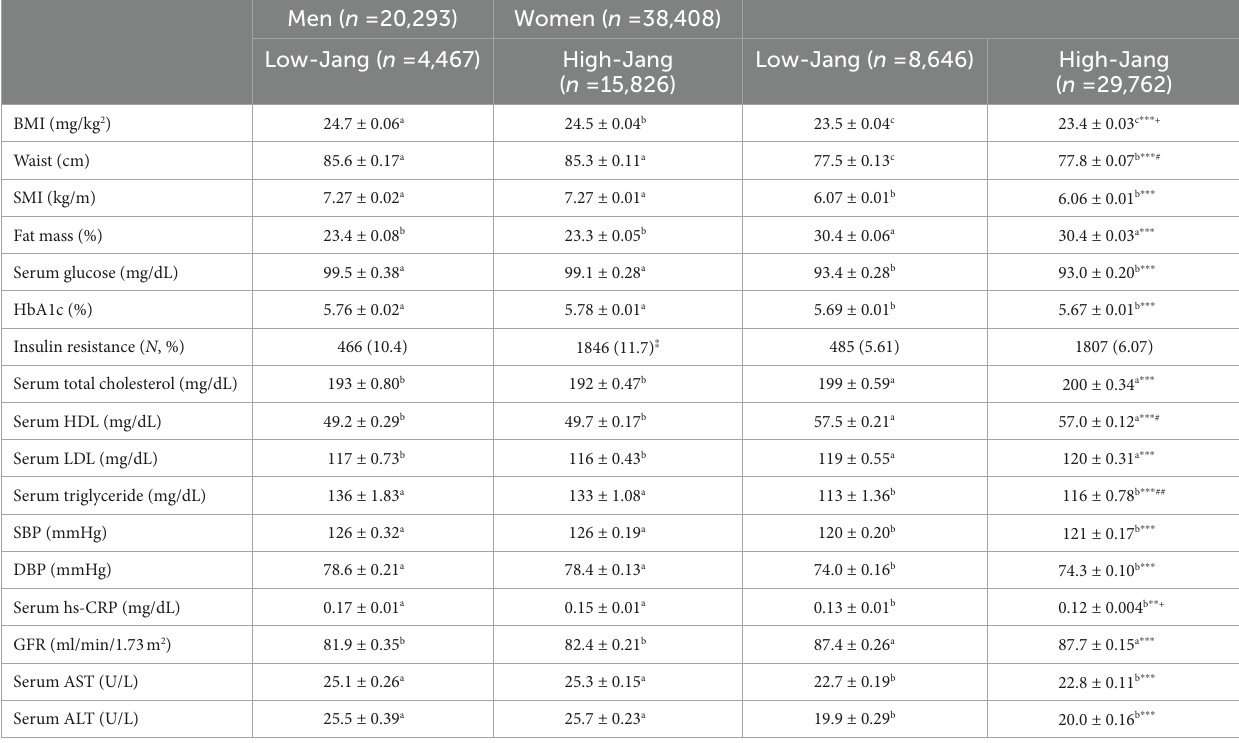
Values represent means and standard deviations for continuous variables and numbers and percentages for categorical variables. The cutoff of Jang intake was 1.9 g/day. Covariates for adjustment included age, energy intake, residence area, education, income, sodium and alcohol intake, smoking status, and physical activity. BMI, body mass index, SMI, skeletal muscle index; HbA1c, hemoglobin A1c; HOMA-IR, Homeostatic Model Assessment for Insulin Resistance (cutoff: 2.32 of HOMA-IR); HDL, high-density lipoprotein; LDL, low-density lipoprotein; SBP, systolic blood pressure; DBP, diastolic blood pressure; hs-CRP, high-sensitive C-reactive protein; AST, aspartate aminotransferase; ALT, alanine